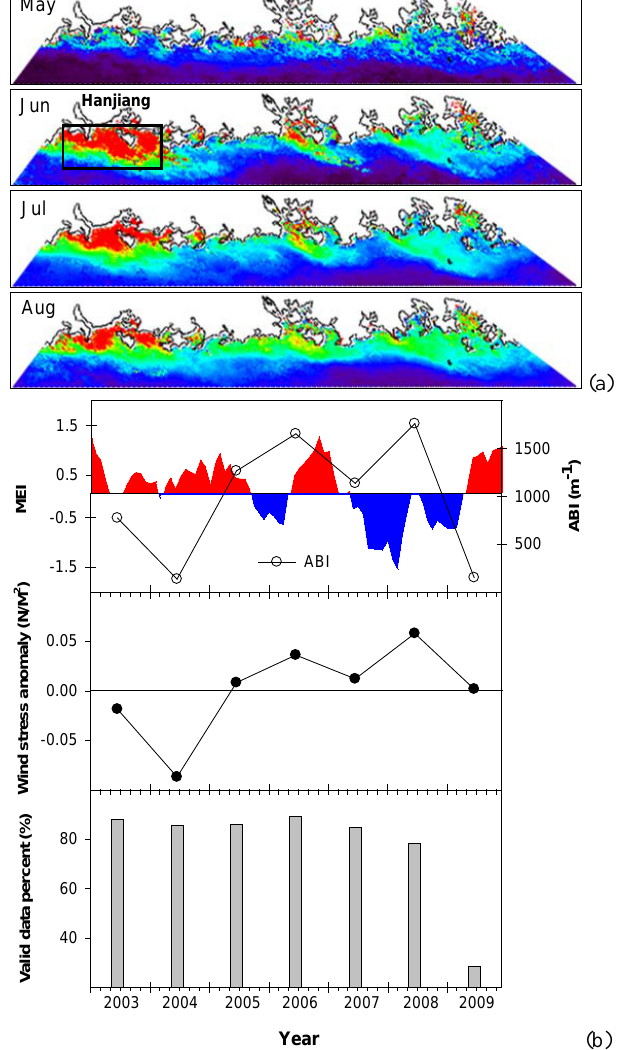
Fig. 5. (a) close-up view of Aph in the nearshore water (west of the white line alongshore on Fig. 4a) in May–August; (b) The interannual variation of Aph percentage of valid retrievals and alongshore wind stress anomaly in the area of Hanjiang River estuary in June during 2003–2009 and the MEI.